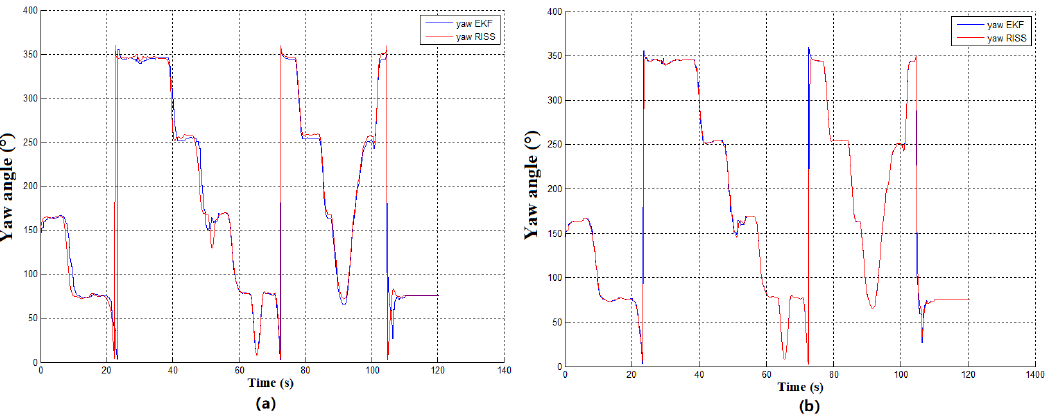
Figure 6. Yaw angle comparison diagram. ( a ) Yaw angle of RISS and EKF navigation system; ( b ) Yaw angle of enhanced RISS and EKF navigation